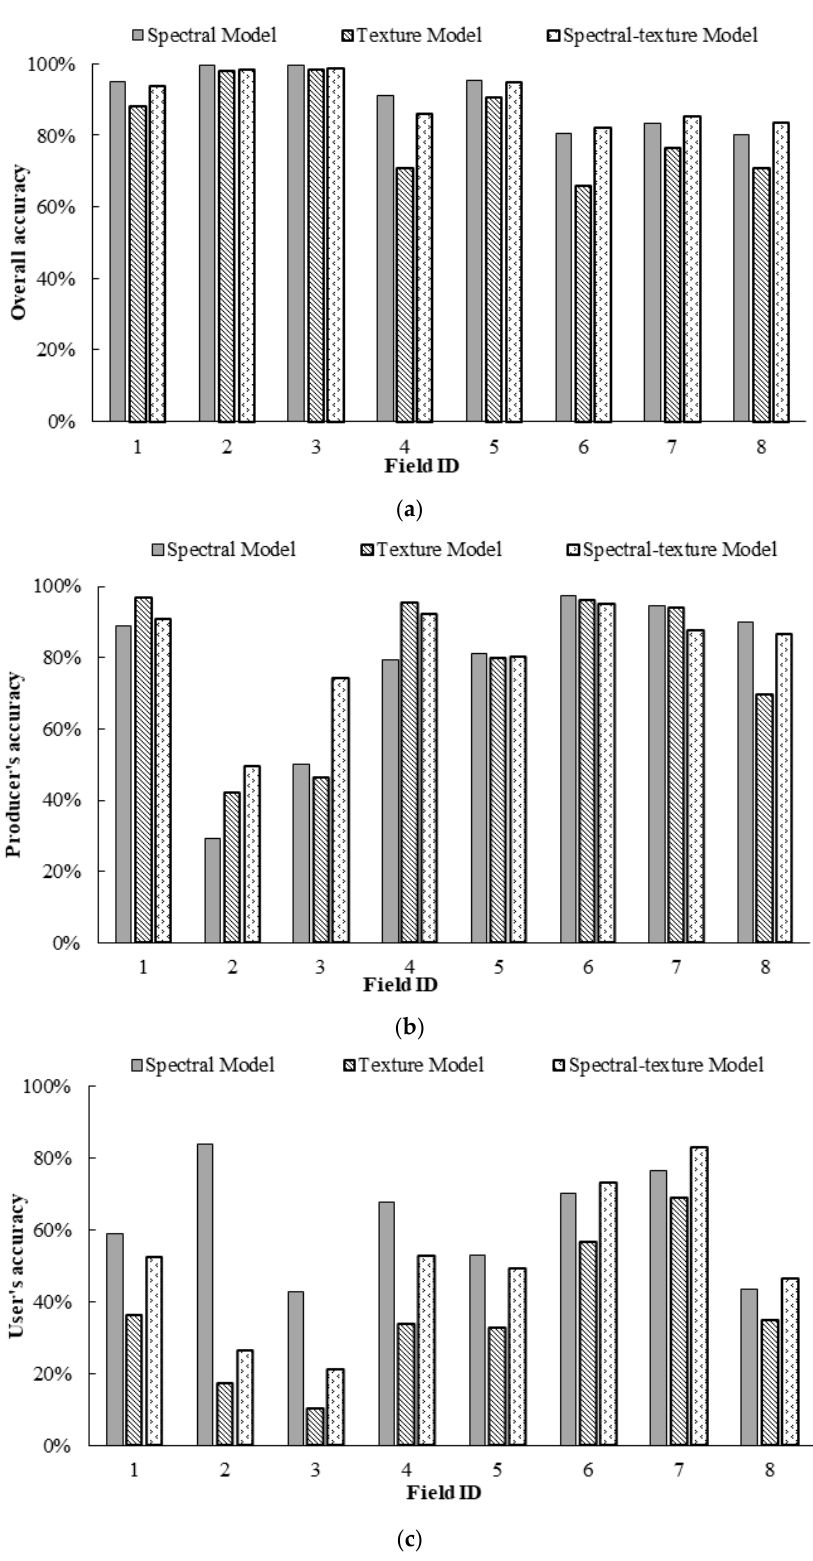
Figure 7. Comparison of classification accuracy of classification maps generated by binary logistic regression (BLR) models: ( a ) overall accuracy (OA); ( b ) producer’s accuracy (PA) for the infested category; ( c ) user’s accuracy (UA) for the infested category.